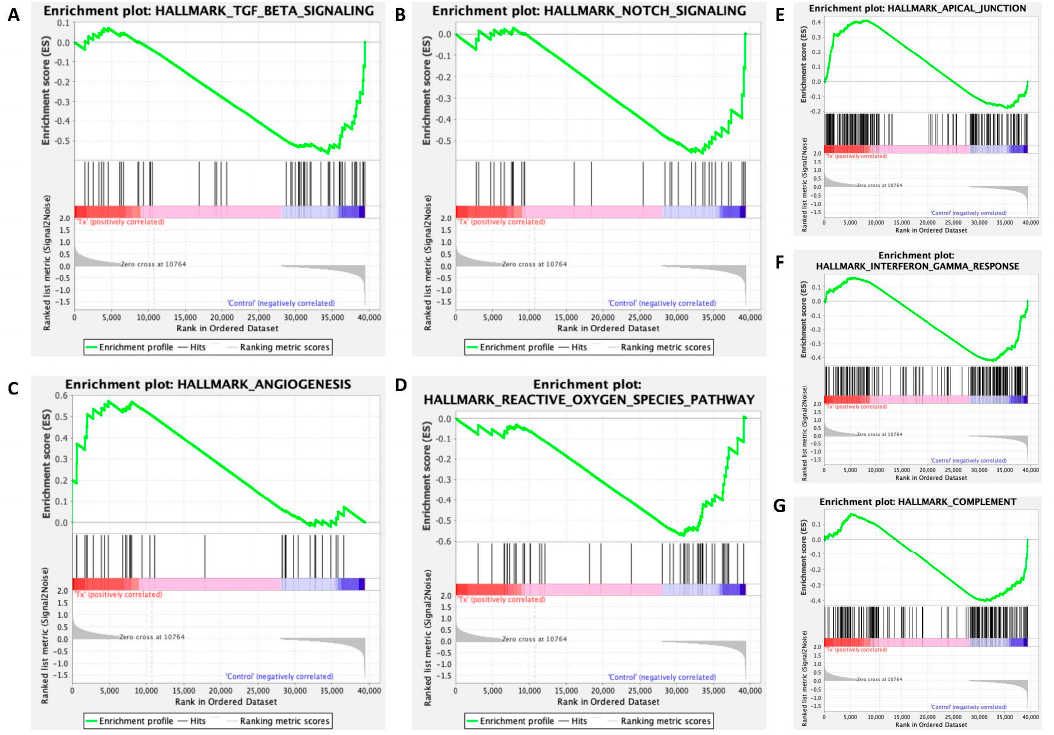
Figure 4. Gene set enrichment analysis (GSEA) of 100 nM asprosin-treated cells at 4 and 12 h combined panel of enrichment score curves: ( A ) TGF Beta Signalling; ( B ) Notch Signalling; ( C ) Angiogenesis; ( D ) Reactive Oxygen Species (ROS); ( E ), Apical Junction; ( F ) Interferon Gamma Response; ( G ) Complement.